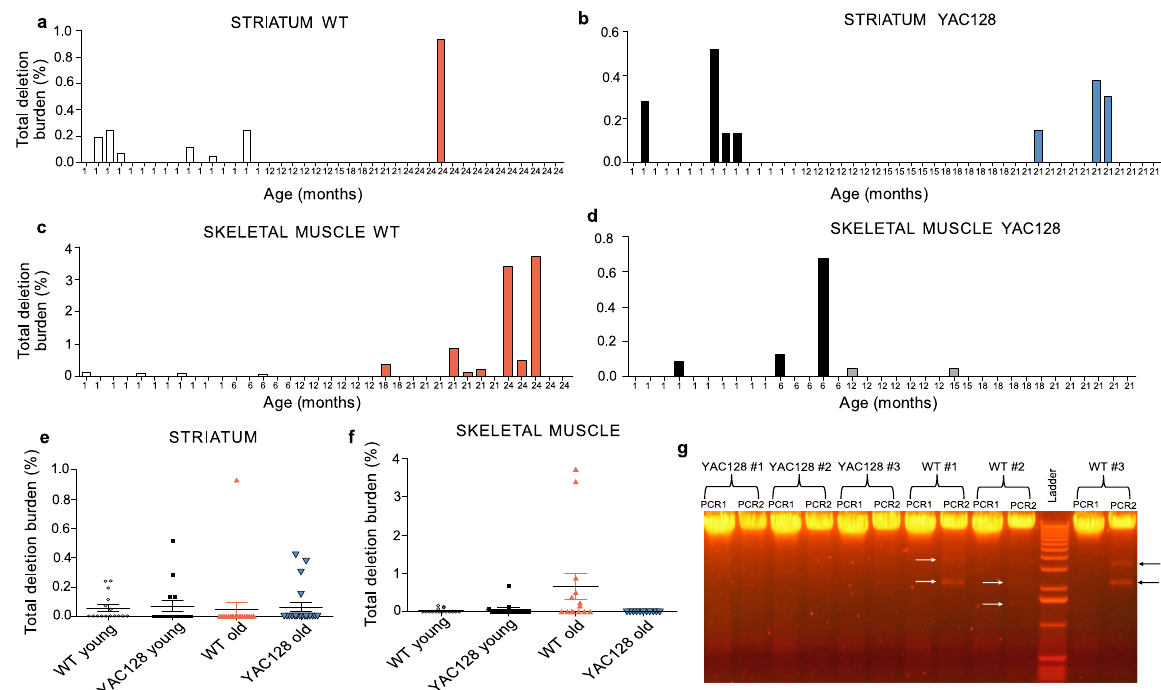
Fig. 3 Distribution of fractions of deleted mitochondrial DNA ( Δ -mtDNA) in striatum and skeletal muscle tissue. a − d Each bar represents the burden of Δ -mtDNA as measured by long-range PCR at the indicated age. Zero-height bars represent samples that were determined to be deletion-free by long-range PCR. In total, a 6/16 WT and b 4/15 YAC128 mice had Δ -mtDNA in striatum at 1 month of age, while c 3/11 WT mice and d 1/10 YAC128 mice had Δ -mtDNA in skeletal muscle. e Age had an effect with increased odds for Δ -mtDNA in striatum of young mice (odds = 3.24, p = 0.048). f Genotype had an effect with increased odds for Δ -mtDNA in skeletal muscle of WT mice (odds = 4.44, p = 0.026). g Representative image of Δ -mtDNA bands in skeletal muscle of three old YAC128 mice (YAC128 #1 – 3) and three old WT mice (WT #1 – 3) (21 – 24 months of age). For each DNA sample, the left lane represents PCR product 1 (PCR1) and the right lane represents PCR product 2 (PCR2). Arrows in black and white indicate detected bands. Number of mice analyzed in striatal tissue: WT young (1 month) n = 16; YAC128 young (1 month) n = 15; WT old (18 – 24 m) n = 19; YAC128 old (18 – 24 months) n = 20; Skeletal muscle (quadriceps): WT (1 month) n = 11; YAC128 (1 month) n = 10; WT (6 months) n = 5; YAC128 (6 months) n = 5; WT old (18 – 24 months) n = 14; YAC128 old (18 – 21 months) n = 11. Binomial generalized linear models were applied for